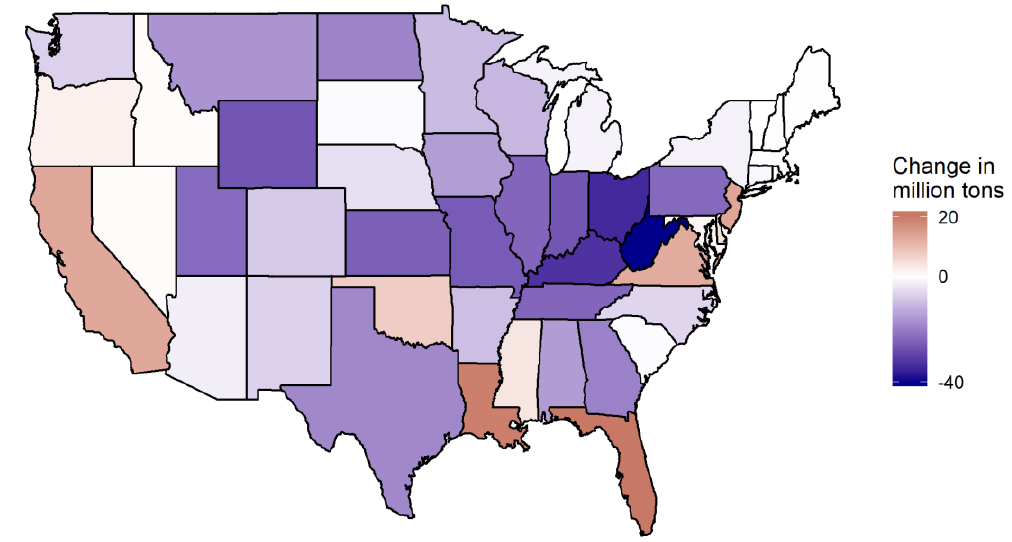
Energies 2019 , 12 , x FOR PEER REVIEW Figure 6. Change in CO 2 e emissions by state after $50 / ton tax. Figure 6. Change in CO 2 e emissions by state after $50/ton tax.